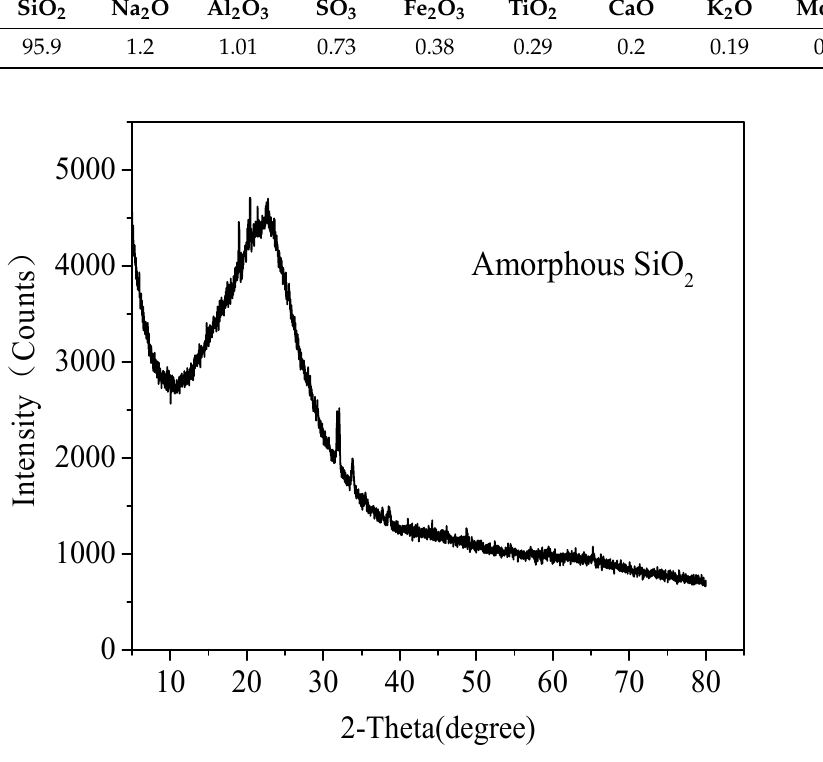
Figure 4. XRD pattern of acid-leached residue.